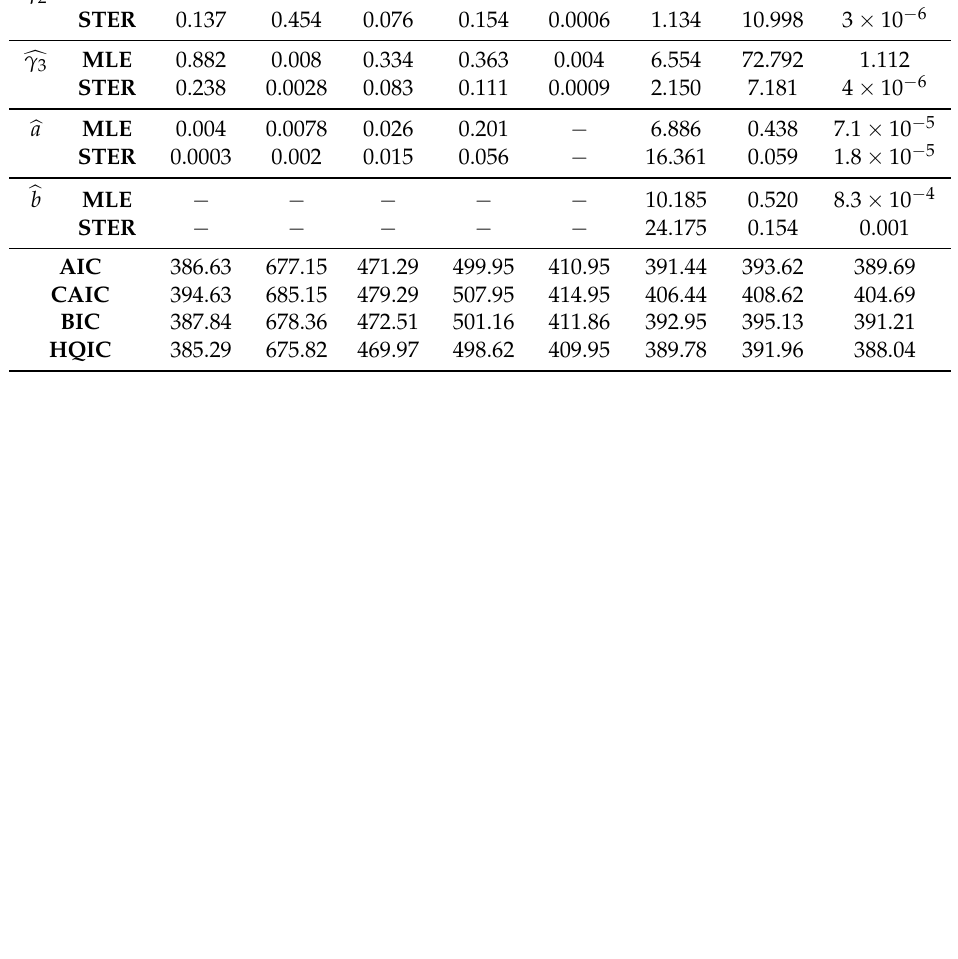
Table 16. The MLE and goodness-of-fit measures based on the censored sample at r = 10.